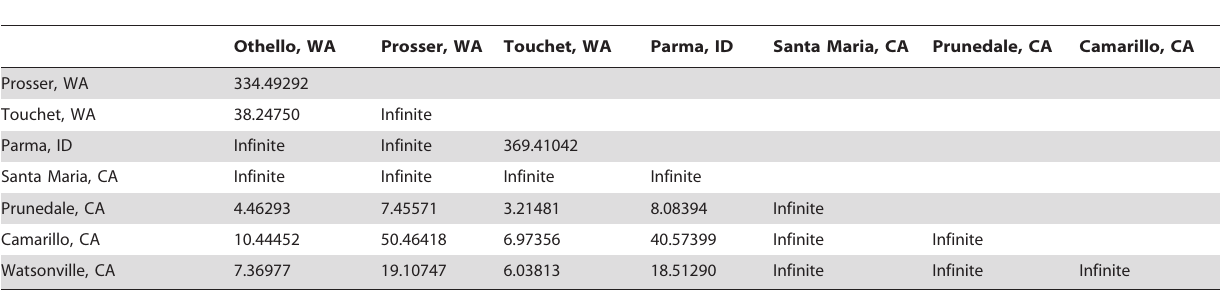
Table 7. Matrix of M values (M =Nm for haploid data) describing predicted gene flow between populations of L. hesperus .